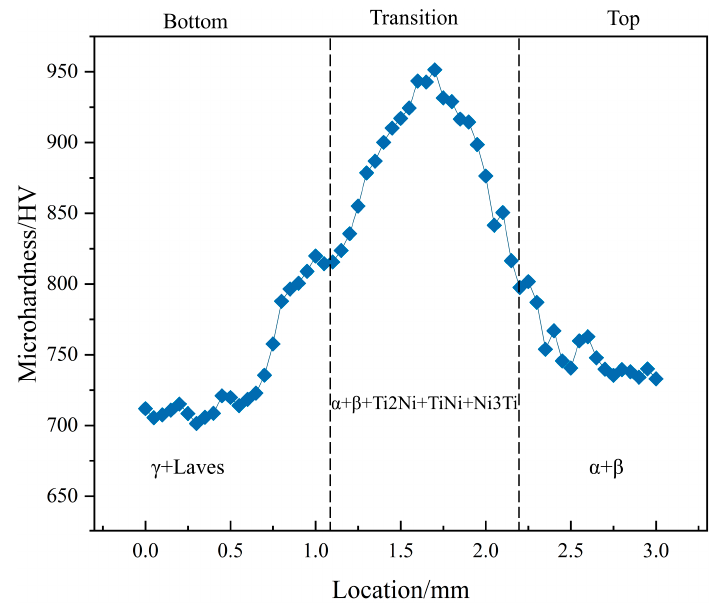
Figure 10. Hardness distribution of Ti6Al4V/Inconel 718 coating.